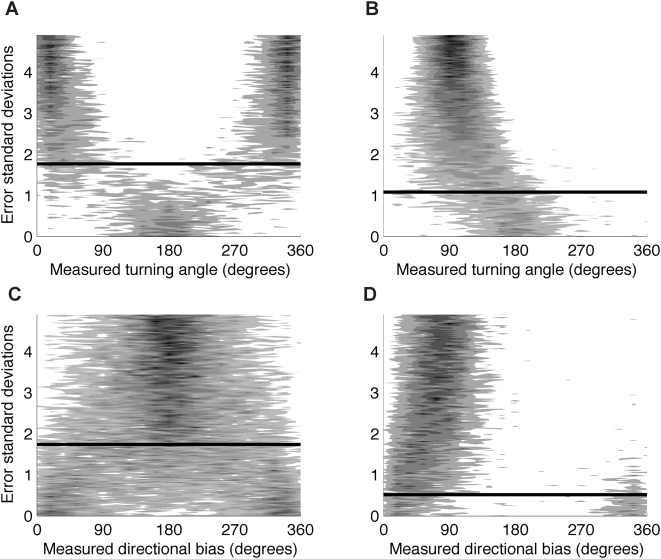
The effect of step length on turning angle and directional bias distributions.The solid line shows the minimum true step length for which the true turning angle or directional bias could be detected. (A) The distribution of measured turning angles where the true turning angle was 0°. Dark colors show more frequent observations. The solid line at 1.76 error standard derivations shows the minimum step length where the null hypothesis that the mean of the measured distribution of turning angles was not equal to the true turning angle was rejected using the V test. For the distribution of measurement error used in this simulation, this corresponds to 7.2 meters. (B) The true turning angle is 90°. The solid line at 1.08 error standard deviations is the minimum true step length where the true turning angles could be detected. This corresponds to 4.4 meters. (C) The distribution of directional biases where the true directional bias was 180°. The minimum error standard deviation where the true directional bias could be detected was 1.74. This corresponds to 7.1 meters. (D) The true directional bias was 90° and the minimum error standard deviation where the true directional bias could be detected was 0.51. This corresponds to 2.1 meters. For all simulations step lengths from 0 to 1.35 error standard deviations by 6.7×10−4 error standard deviations were simulated. For each step length one hundred turning angles were generated. The distance from the true location to the measured location was modeled as a Bessel distribution with ρ = 0.303.